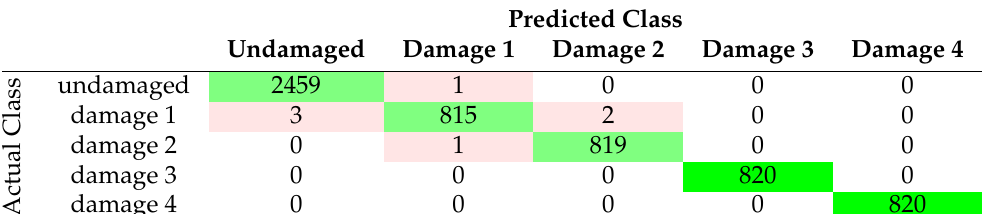
Table 9. Total added confusion matrix for d = 14. Correct decisions are placed in cells with green background while wrong decisions are placed in cells with red background.